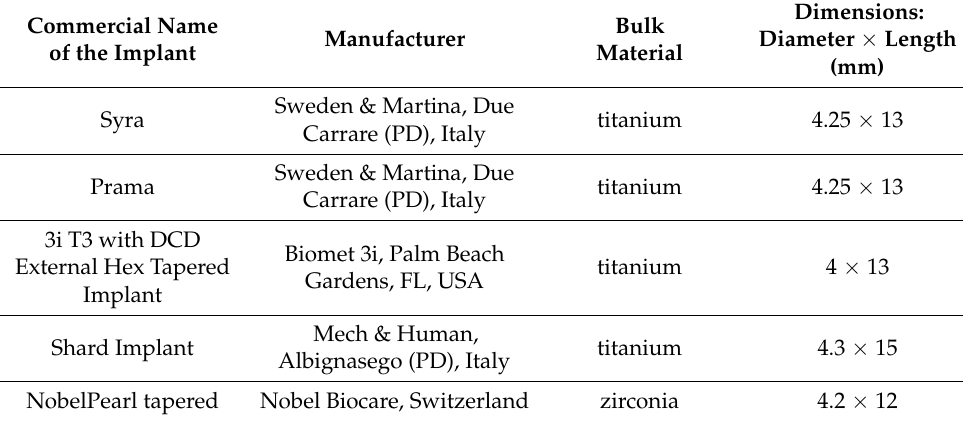
Table 1. List of the dental implants tested in the present